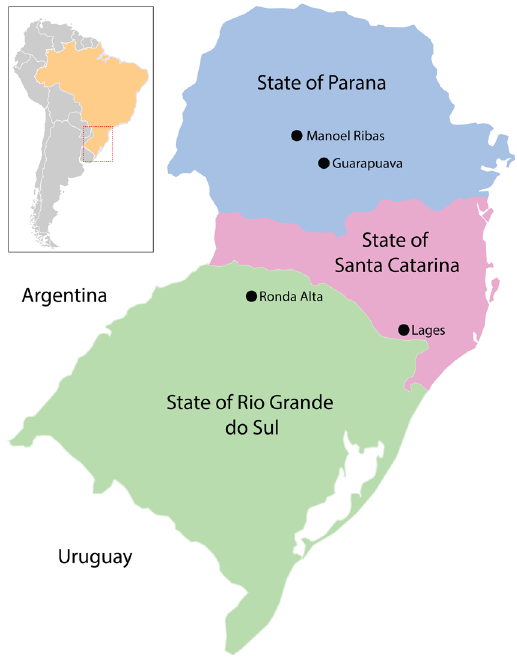
Figure 5. Map of sample collection sites in the southern region of Brazil. Black dots represent the name of the collection sites in each